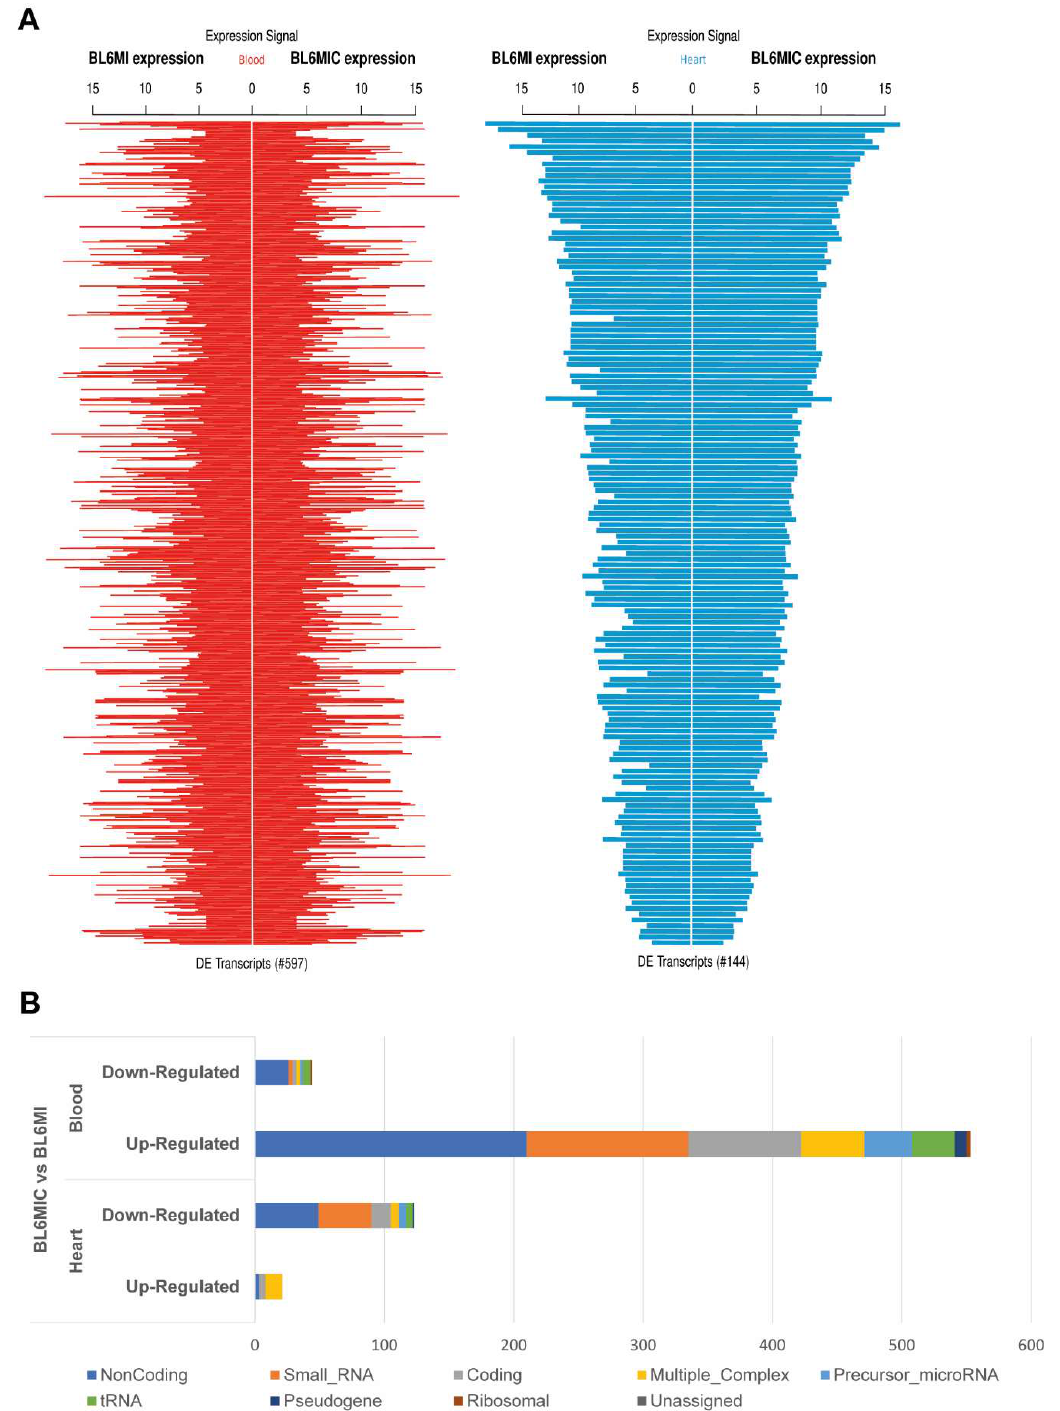
Figure 4. Transcriptomic analysis of the heart and blood. C57BL/6J mice were subjected to MI, MIC and seven days later, the RNA from the heart and blood was isolated and analyzed via a Clariom TM D microarray. ( A ) The log(2) scale expression signals of the differentially expressed (DE) transcripts between the cell treated (BL6MIC) and infarct (BL6MI) groups are illustrated as Manhattan plots. DE transcripts in the blood are shown in red while the DE transcripts from the heart are shown in blue. Transcripts are considered DE, if they show a two-fold change and have a p- value < 0.05. ( B ) The relative contribution of the various categories of RNA to these differentially expressed transcripts in the heart and blood ( n = 3).